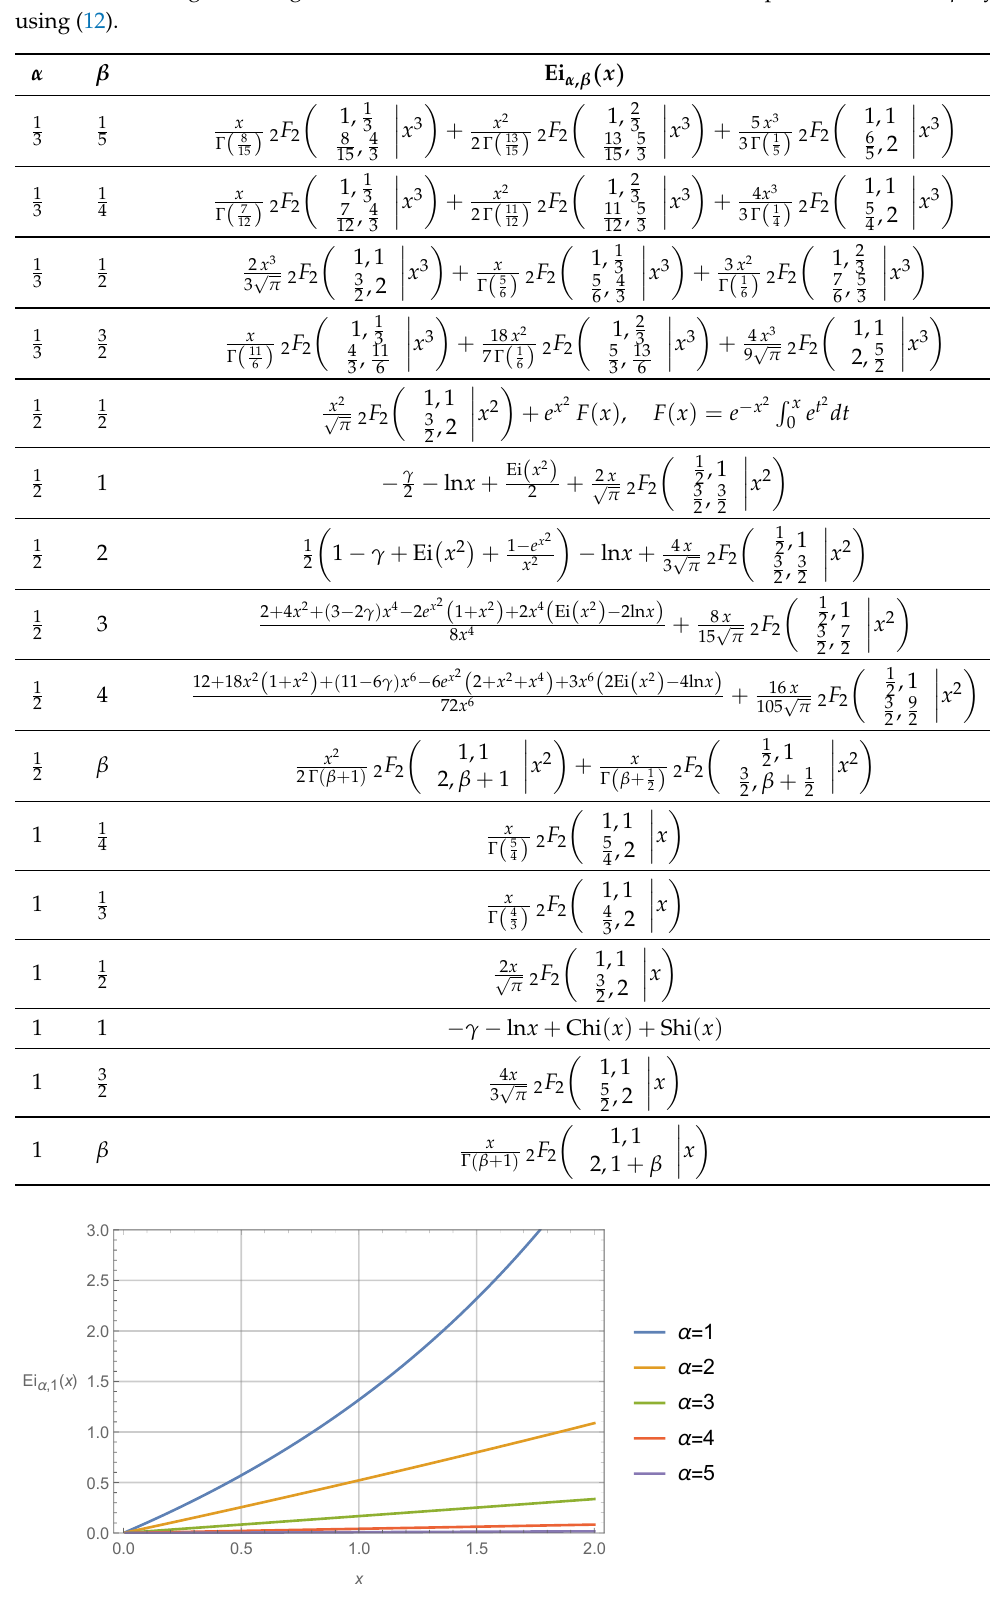
Figure 1. The integral one-parameter Mittag-Leffler function Ei α ,1 ( x ) as a function of variable x and parameters α